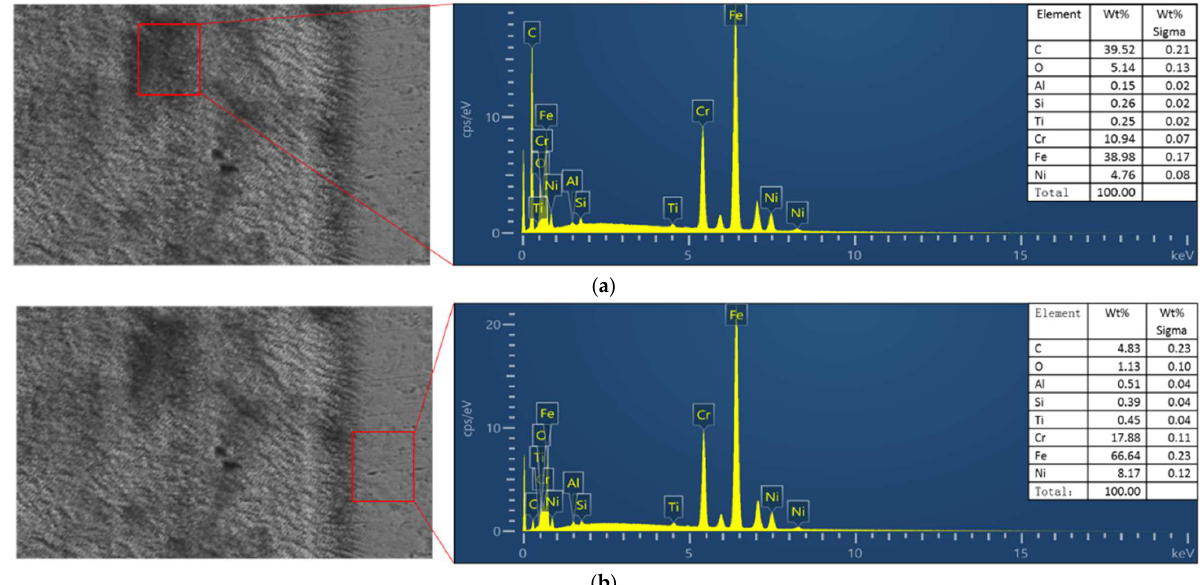
Figure 4. Comparison of elemental composition of black oxide in ( a ) ablation area and ( b ) no abla- tion area.